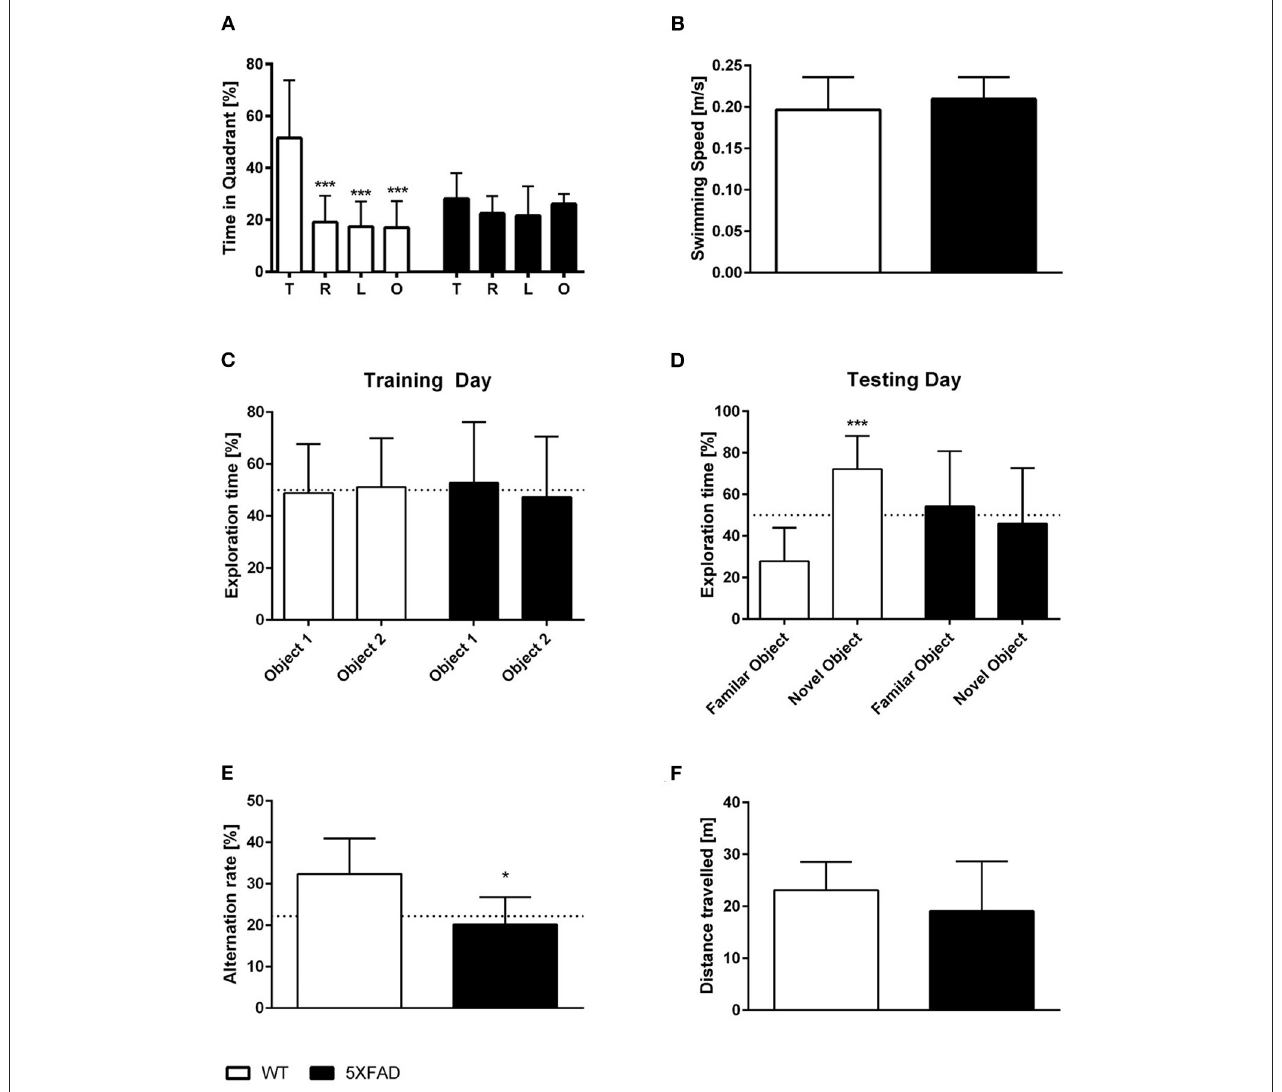
FIGURE 4 | Memory deficits in female 7-month-old 5XFAD mice. (A) 5XFAD mice displayed an impaired spatial reference memory in the probe trial of the Morris water maze as they displayed no preference for the target quadrant. In contrast, WT animals showed a clear preference for the target quadrant. (B) Swimming speed did not differ between WT and 5XFAD mice. (C,D) In addition, 5XFAD mice displayed an impaired objection memory. (C) During the exploration phase, both genotypes spent ∼ 50% of their time exploring each of the two similar objects. (D) However, only WT mice showed a preference for the novel object on the testing day. (E) Impaired working memory in 5XFAD mice demonstrated in the cross maze (dotted line indicates chance level). (F) There was no difference in the total distance traveled between 5XFAD and WT mice in the cross maze. (A) One-way ANOVA followed by Bonferroni multiple comparisons (B,E,F) unpaired t -test, (C,D)